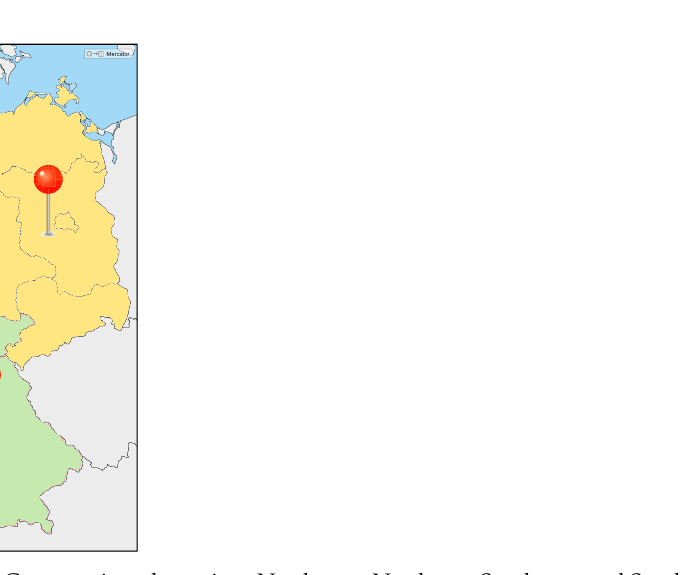
Figure 1. Segmentation of Germany into the regions Northwest, Northeast, Southwest and Southeast with their respective reference locations.